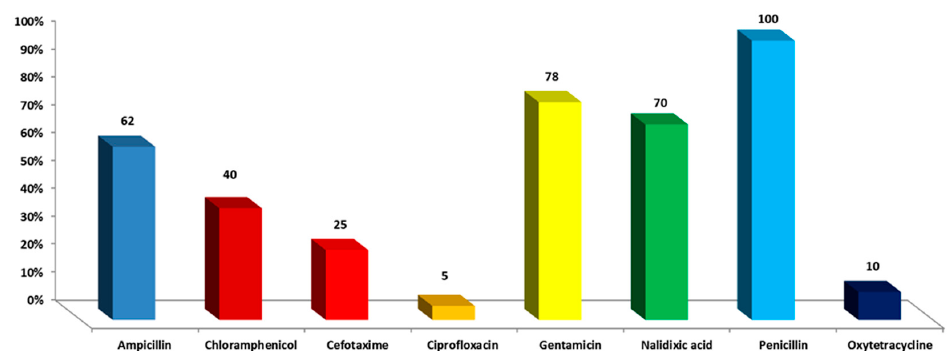
Figure 2. Comparison of drug resistance patterns of S. enterica isolates against studied antimicrobial agents.